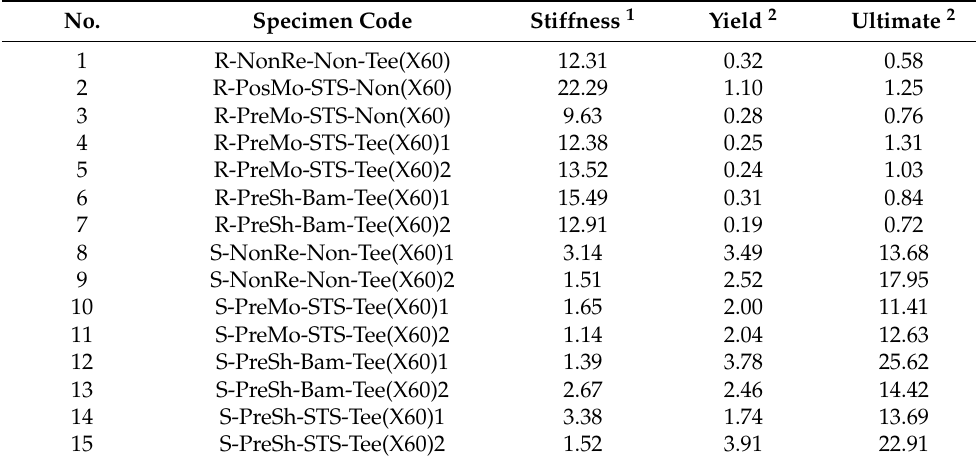
Table 5. Results of rotational and shear tests.